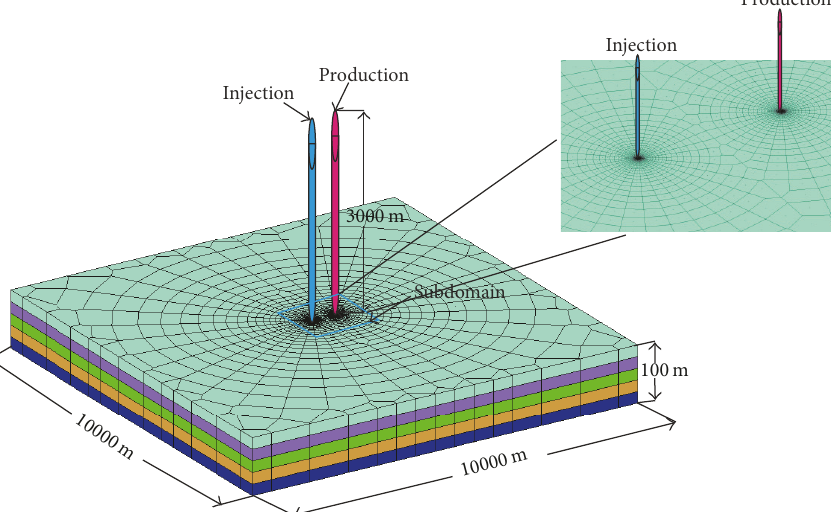
Figure 1: Two-spot reservoir-wellbore concept model with grid dissection.